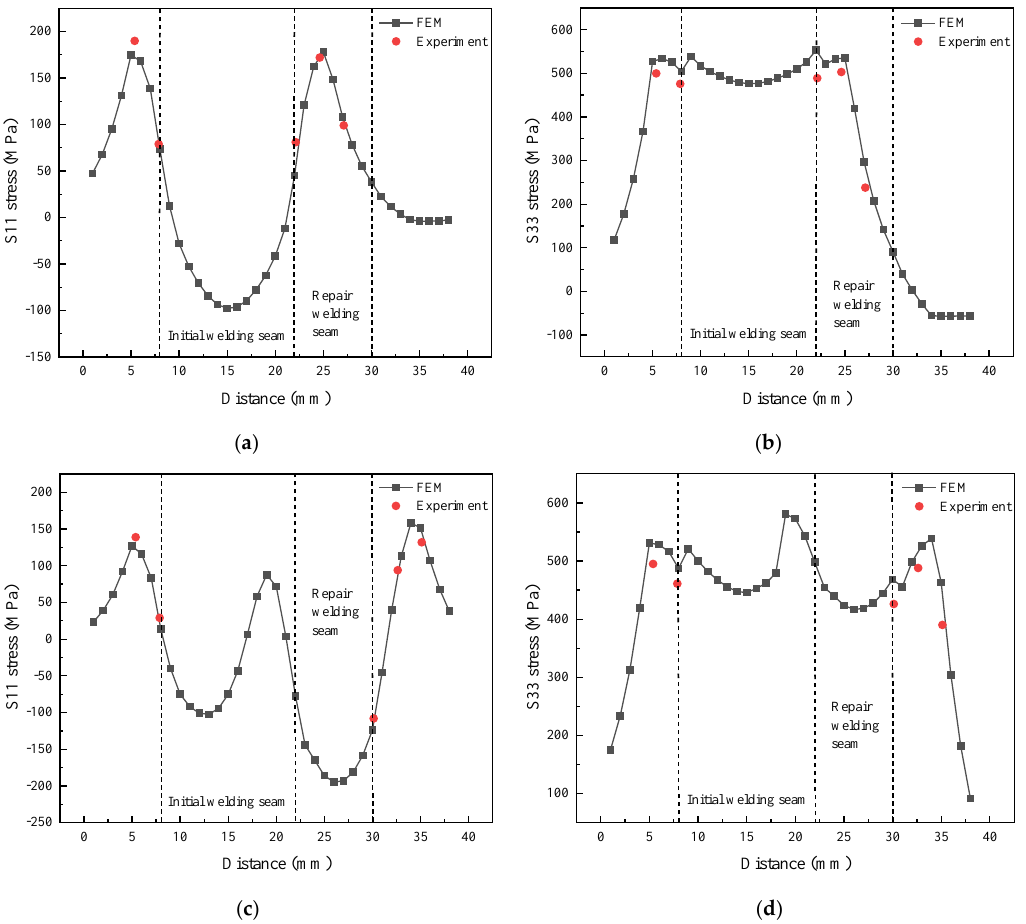
Figure 15. Comparison of the residual stress obtained from FE simulations and experiments: ( a ) S11